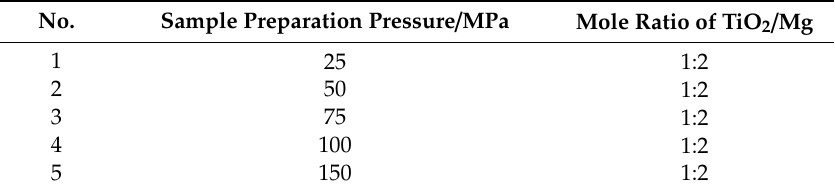
Figure 1. TiO 2 raw material particle size distribution. Table 1. Self-propagating high-temperature synthesis mode (SHS) reaction conditions.